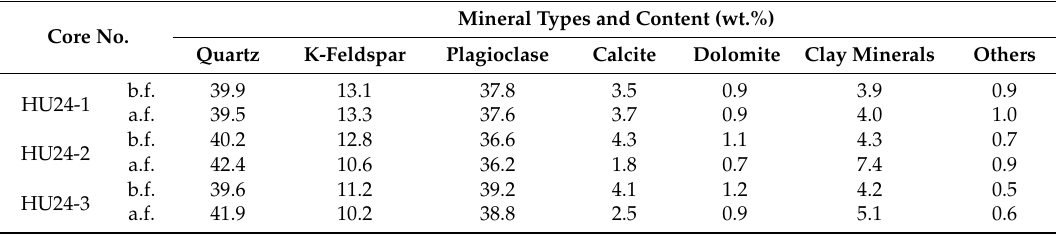
Table 8. Types and contents of mineral in the core samples before and after